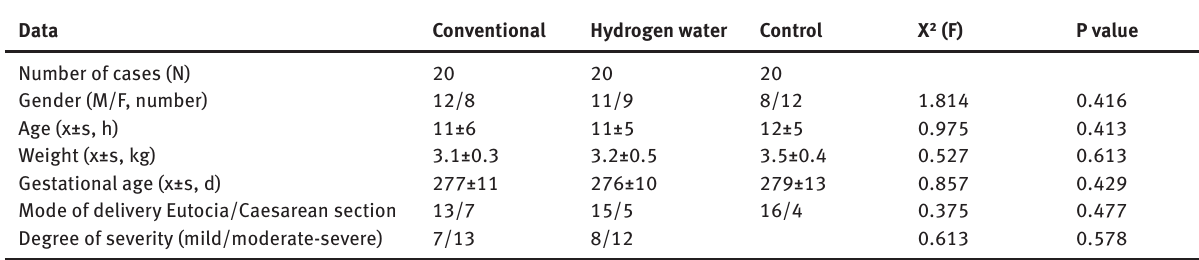
Table 1: Patient data for the three groups.